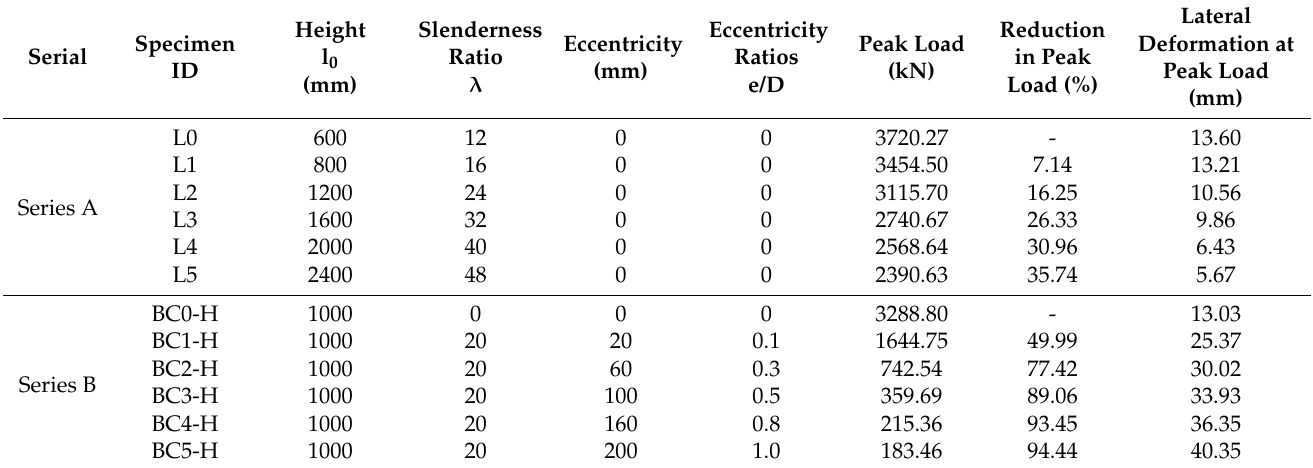
Table 1. The test matrix and the test results of column